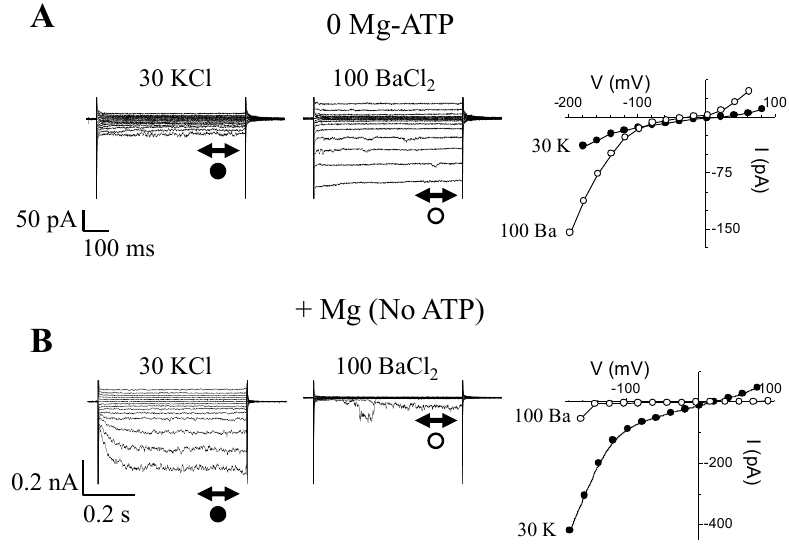
Figure 6. Internal Mg 2 + is responsible for I Ba inhibition. ( A ) Currents (left panel) and corresponding I-V plots (right panel) from the same guard cell recorded in response to hyperpolarizing voltage steps (from + 64 to − 196 mV; in − 20 mV increments; h v = − 36 mV) and in the absence of Mg-ATP using either K + (30 mM) or Ba 2 + (100 mM) as charge carriers. Notice the larger I Ba compared to I K,in . ( B ) Current (left panel) and corresponding I-V relationships (right panel) recorded in the same external conditions as in ( A ), but this time using only Mg 2 + ions in the patch solution (1 mM added as MgCl 2 ) and no added ATP. In these conditions, the predominant current activated by hyperpolarization is I K,in , not I Ba .